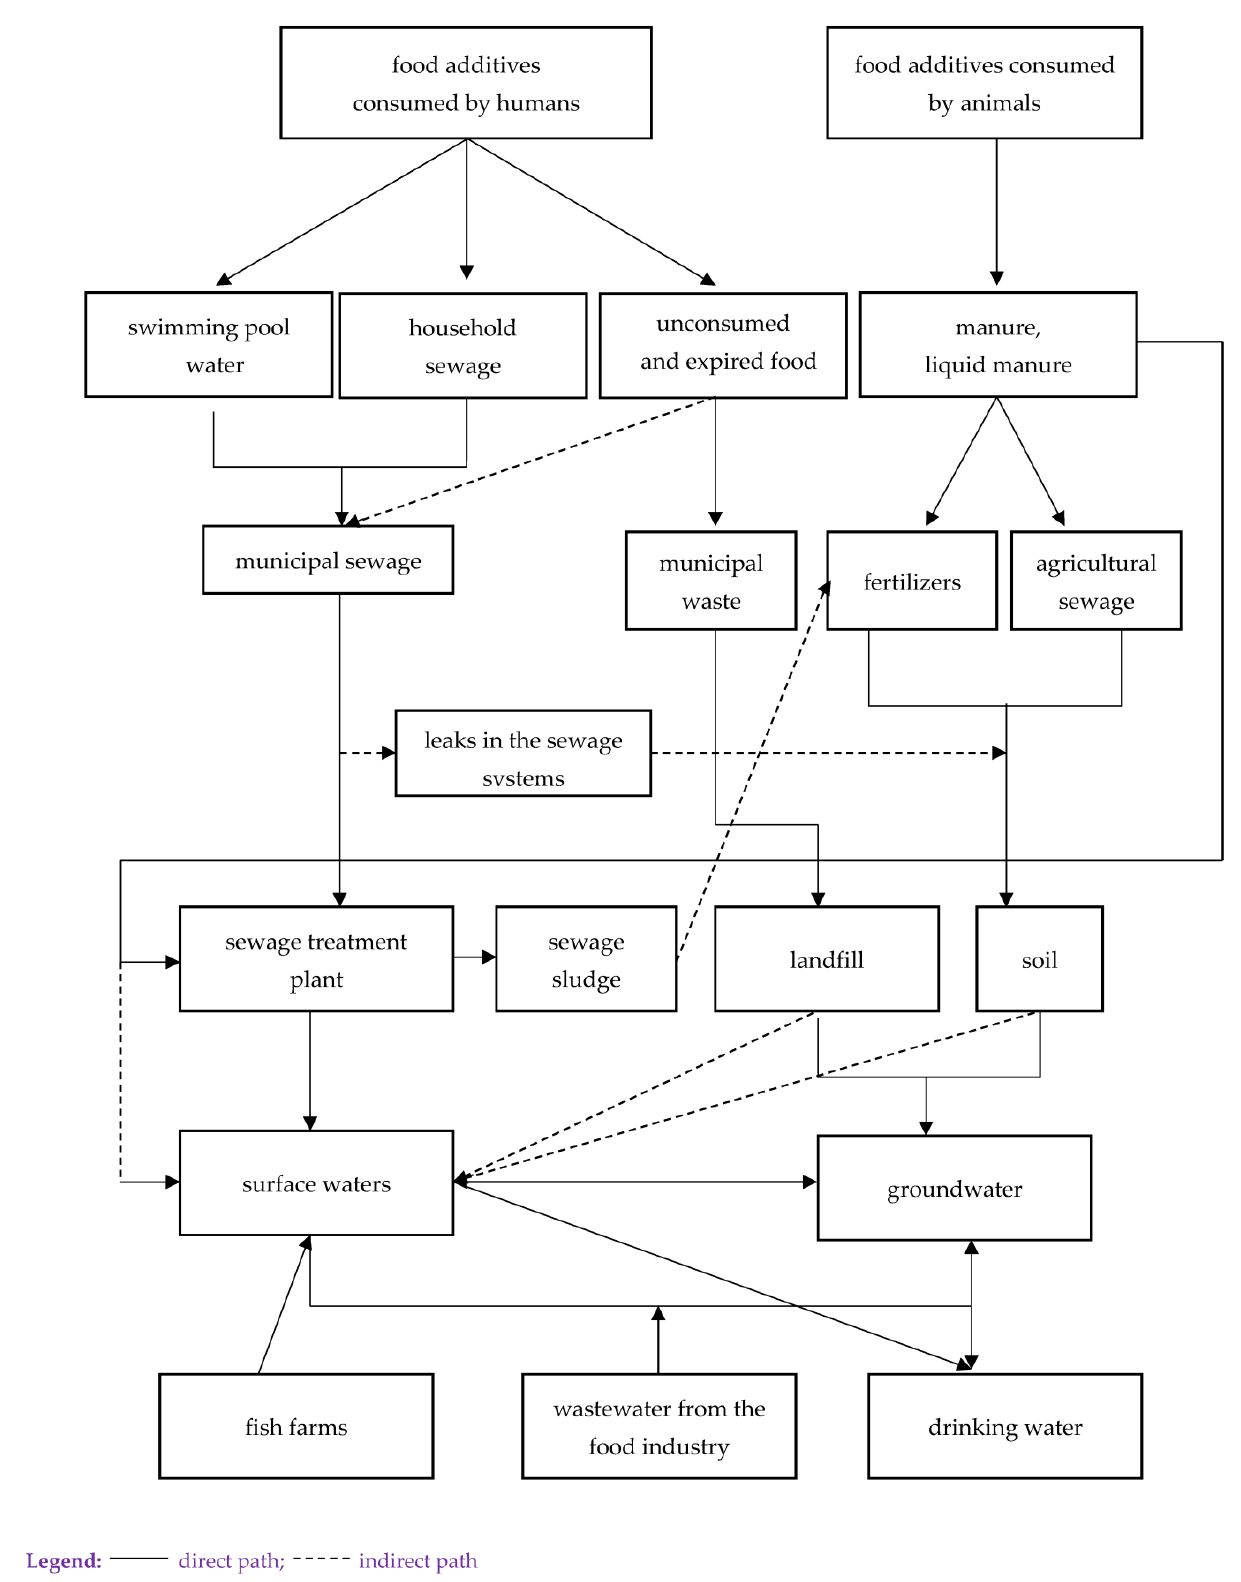
Figure 1. Pathways of food additive penetration into the environment.